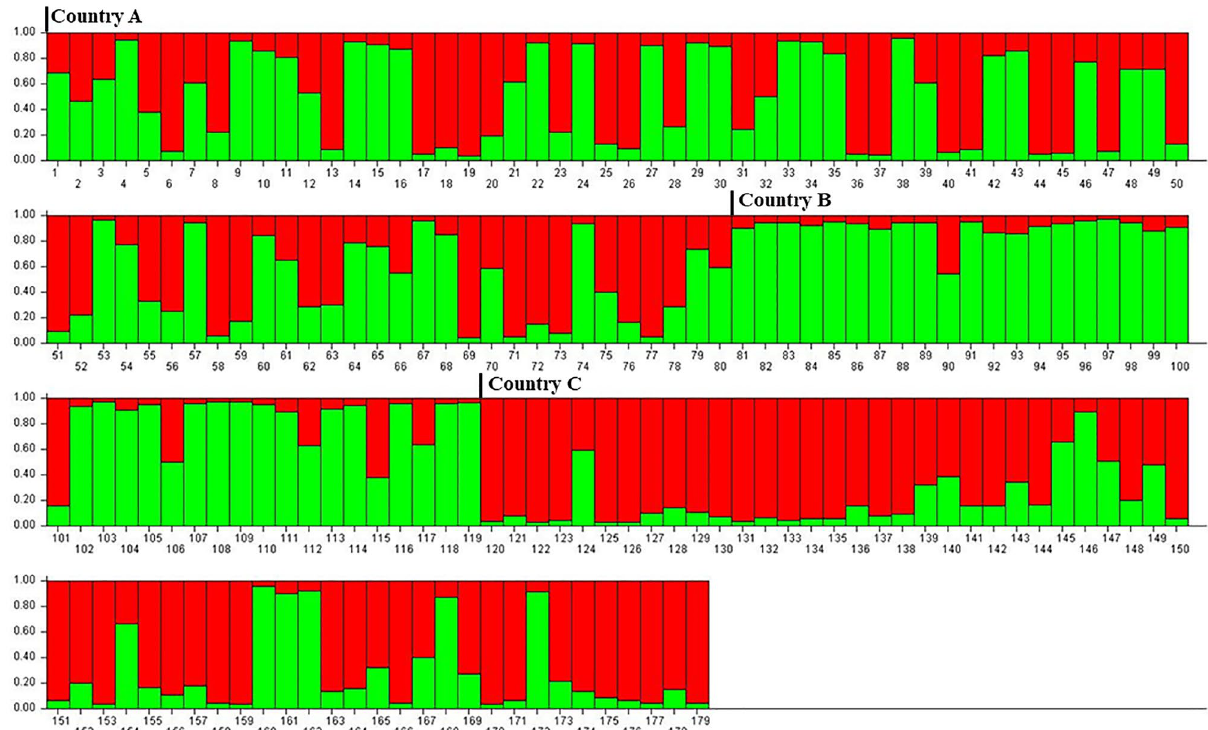
Figure 6. Genetic variability and population structure of the hatchery populations under study. For an overall estimated K = 2 (red, green), the admixture pattern of each individual larvae sample analysed is provided to indicate the contribution of each of the two genetic origins (K). A clear differentiation of admixture patterns is evident by country, with a domination of one origin (green) in country B and the domination of the other origin (red) in country